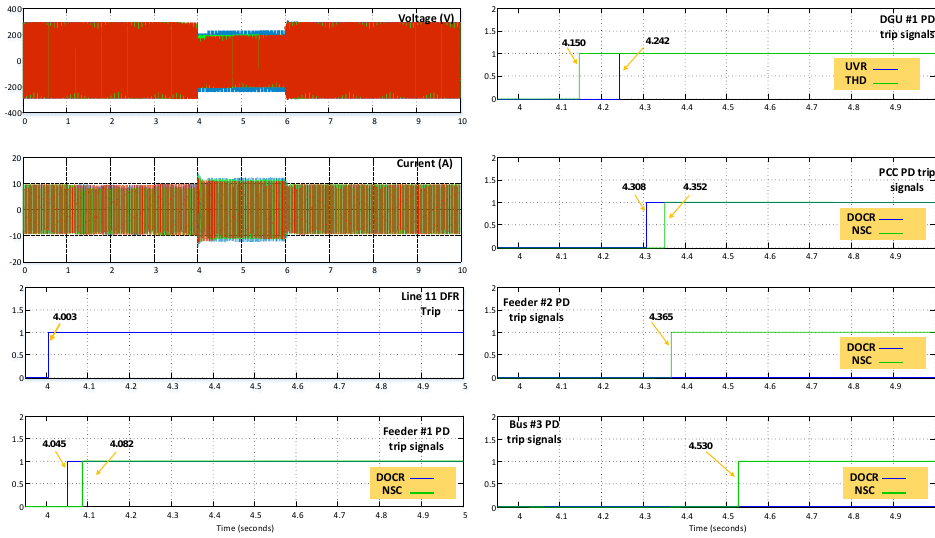
Figure 10. Voltage and current waveforms of DGU #2 during an ABG fault and coordinated trip signals for Fault #2 in grid-connected